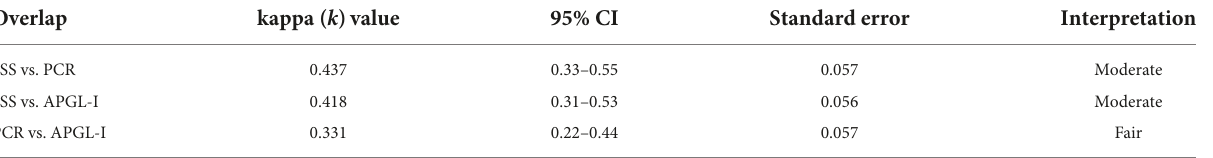
TABLE 3 Concordance among the SSS, PCR and APGL-I results in HDP. Overlap